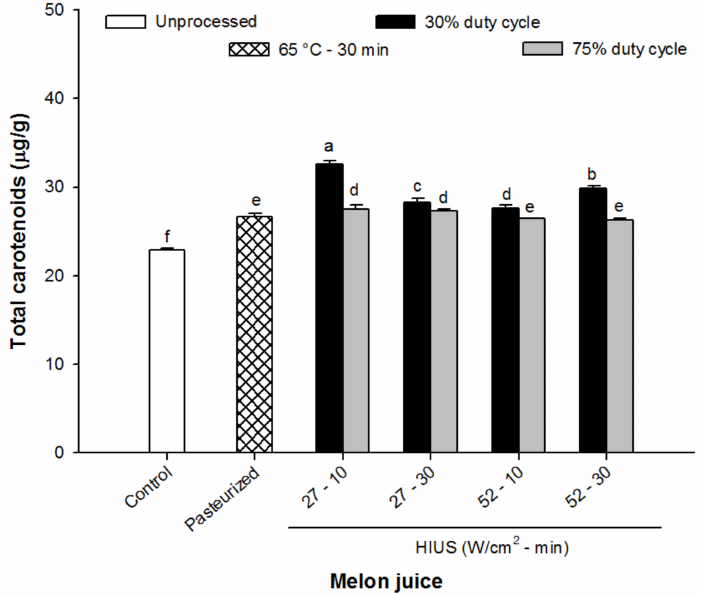
Figure 3. Total carotenoids content of control (unprocessed), pasteurized and HIUS processed melon ( Cucumis melo ) juice. Different letters above the bars indicate statistical difference in treatments ( p < 0.05) ( n =